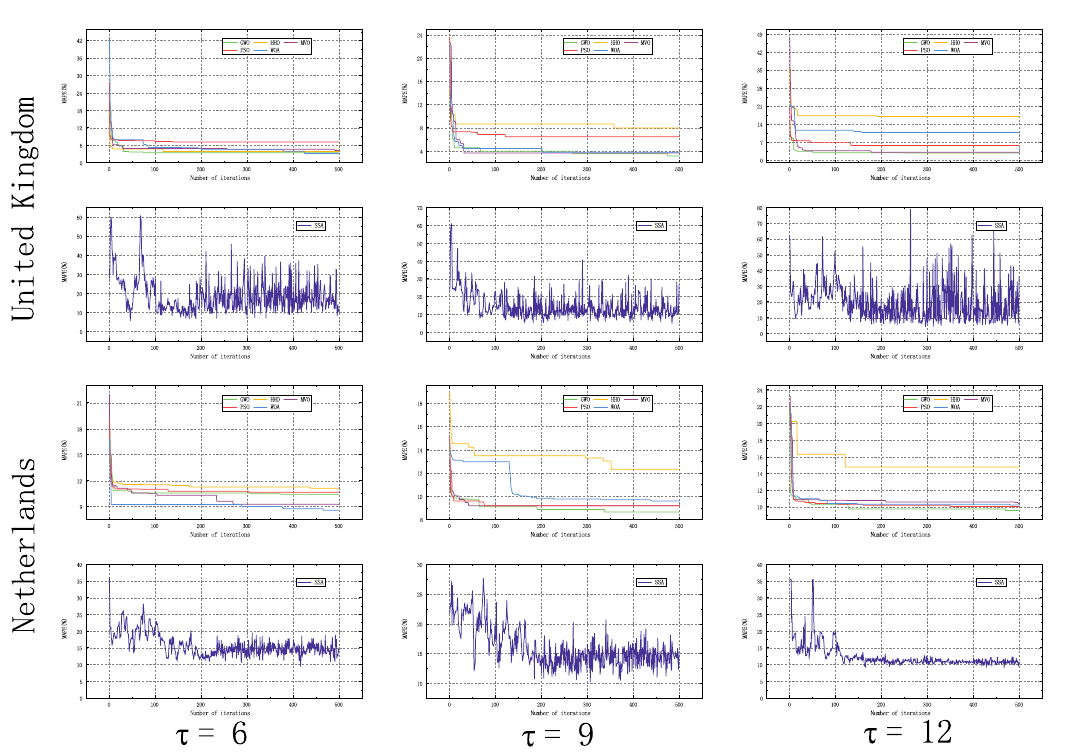
Figure 9. Convergence curves by GWO, HHO, MVO, PSO, WOA and SSA for RF in different